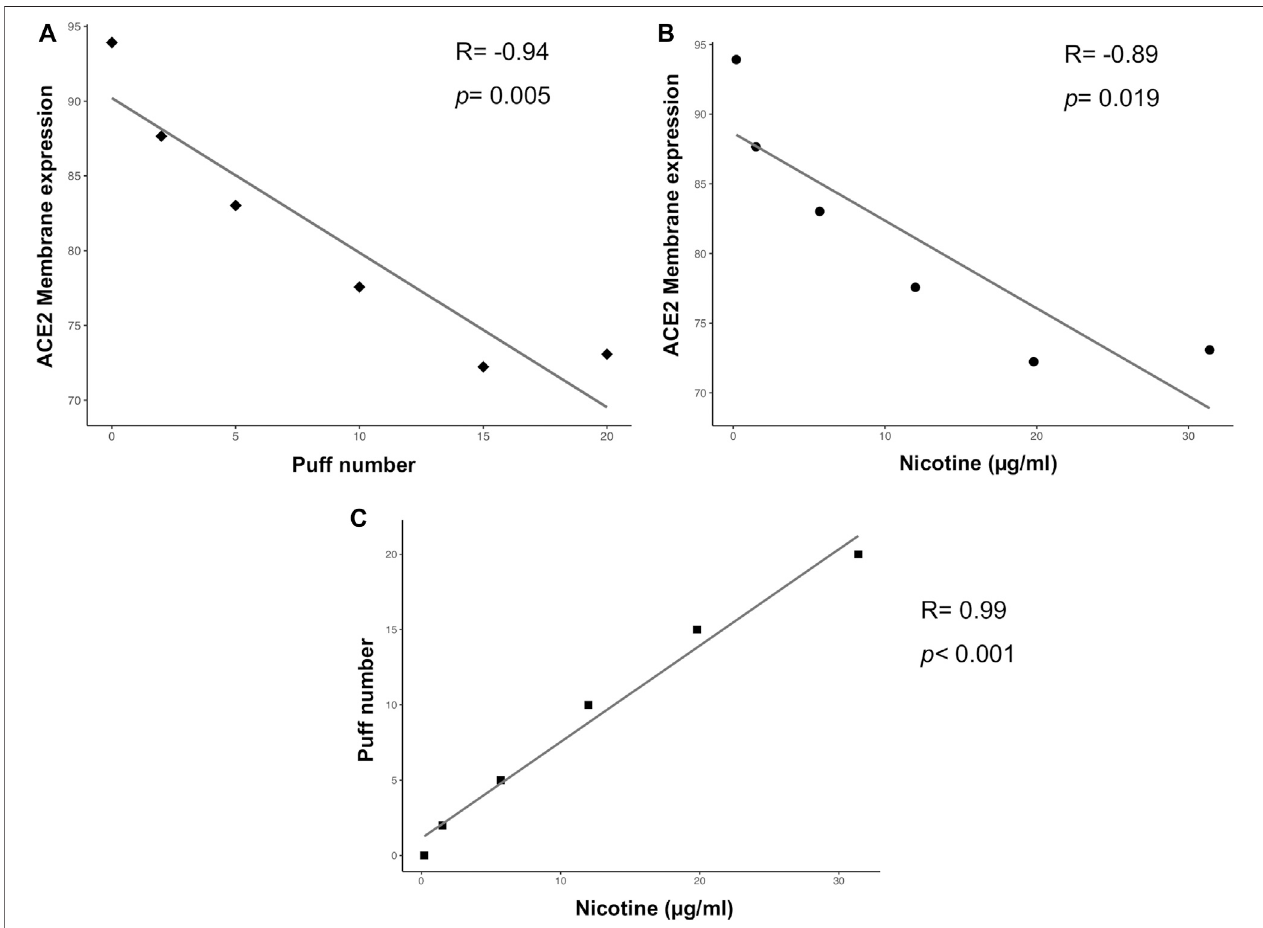
FIGURE 5 | Scatter plots of correlation analyses of membrane ACE-2 protein expression on H292 cells vs puff number (A) and nicotine dosage (B) , and puff number vs nicotine dosage (C) . Correlations were determined using Pearson ’ s ρ correlation.